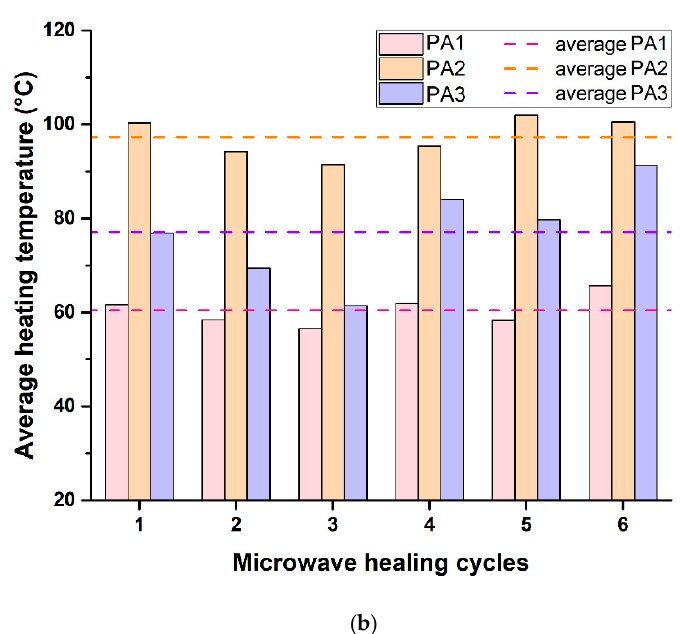
Figure 4. Maximum temperature after microwave heating: ( a ) temperature vs. heating time and ( b ) maximum temperature during healing cycles.